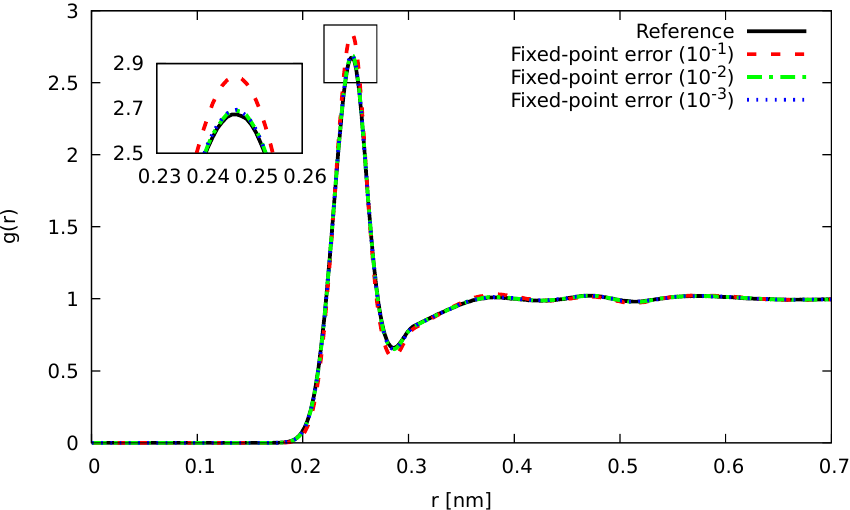
Figure 1. Partial pair correlation function for liquid Si at 3000 K with noisy forces introduced by fixed-point errors of magnitude 10 − 3 (blue), 10 − 2 (green), and 10 − 1 (red). For comparison, the results, as obtained by our reference calculations without noise, are shown in